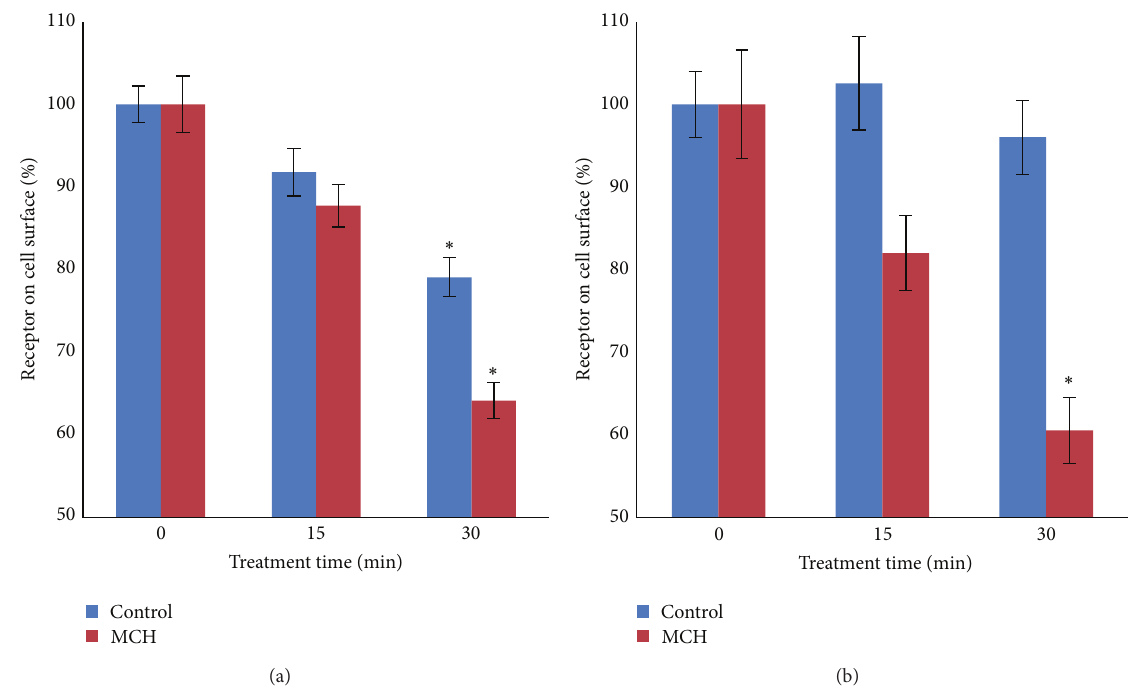
Figure 3: Coexpression of MCHR1 with 𝛽 -arrestin 1 or 2 enhances MCH-mediated receptor internalization. BHK cells were cotransfected with 1 𝜇 g each plasmids encoding VSVg-MCHR1 and (a) GFP 𝛽 -arrestin 1 or (b) GFP 𝛽 -arrestin 2 or GFP control plasmid (both (a) and (b)). The loss of MCHR1 from the plasma membrane in response to 1 𝜇 M MCH was measured using a modified cell-based ELISA protocol. Background signal from mock-transfected cells was subtracted. For 𝛽 -arrestin 1, 𝑛 = 21 (7 triplicate experiments); for 𝛽 -arrestin 2, 𝑛 = 15 (5 triplicate experiments). Ave ± SEM plotted. ∗ 𝑃 < 0.01